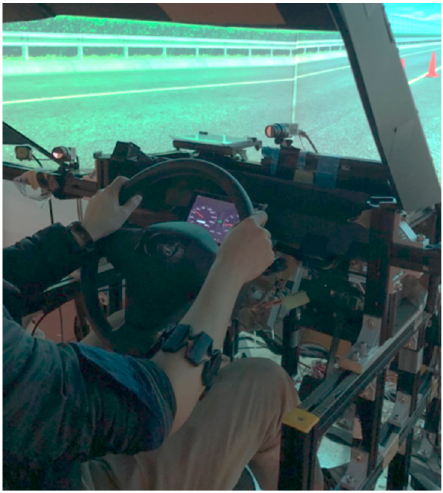
Figure 1. Active steering system and armband worn by driver to enable sEMG-based operation of a high-fidelity driving simulator.